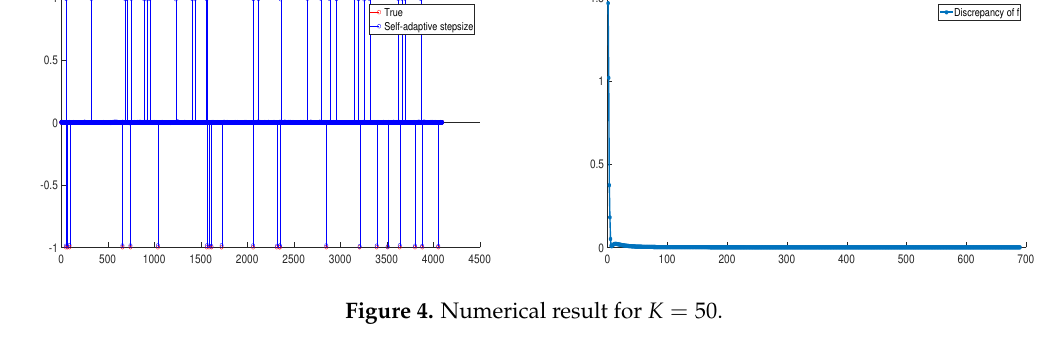
Figure 4. Numerical result for K = 50.